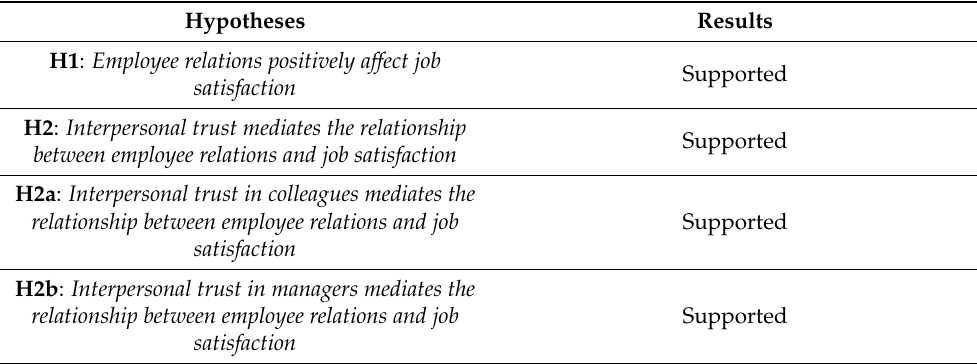
Table 8. Results of hypothesis